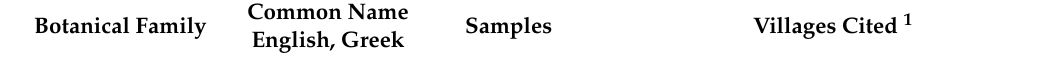
Table 3. Landraces; aromatic, medicinal, and wild edible plants; and perennial local varieties reported in interviews and collected accessions during the AUA expeditions in